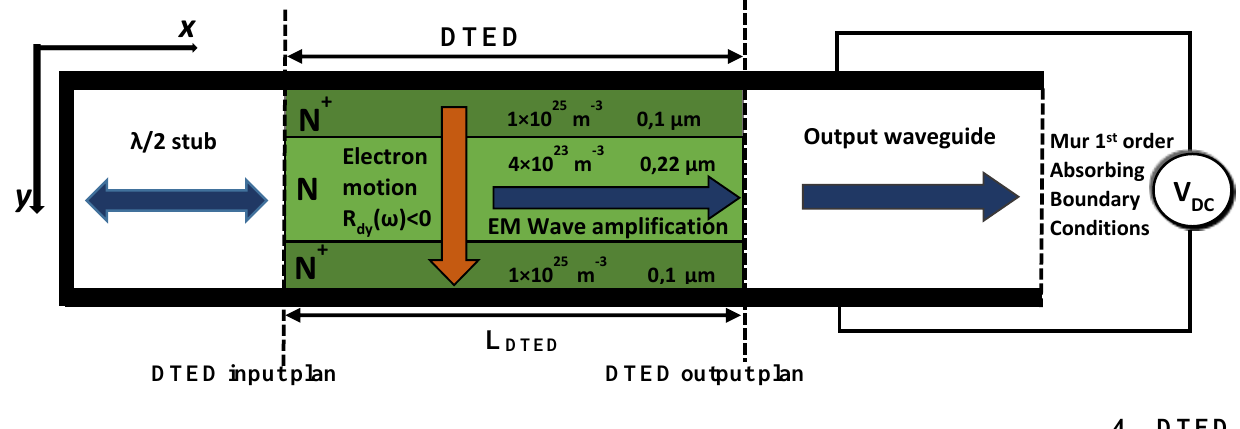
Figure 3: Parallel waveguide GaN THz DTED oscillator